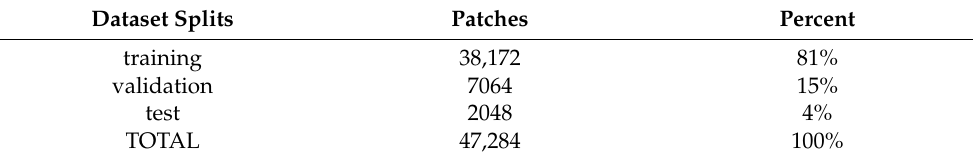
Table 1. Dataset splits used for model development. Test set from tile +14, −40 (Figure 1). Dataset Splits